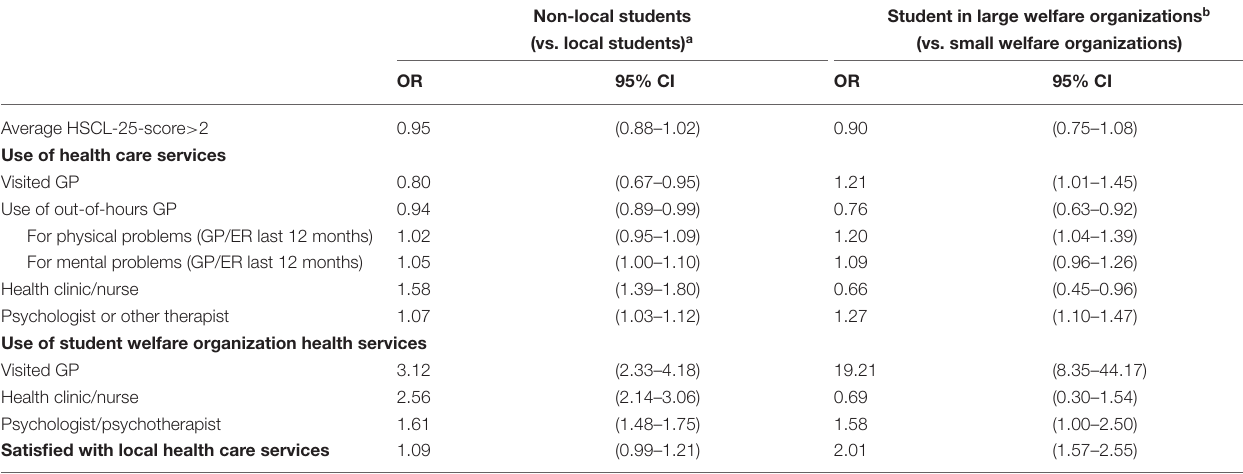
TABLE 2 | Binary associations between use of health services in non-local ( N = 31,714) vs. local students ( N = 15,648) and students belonging to large ( N = 31,722) vs. small ( N = 15,756) student welfare organizations, presented as odds ratios.